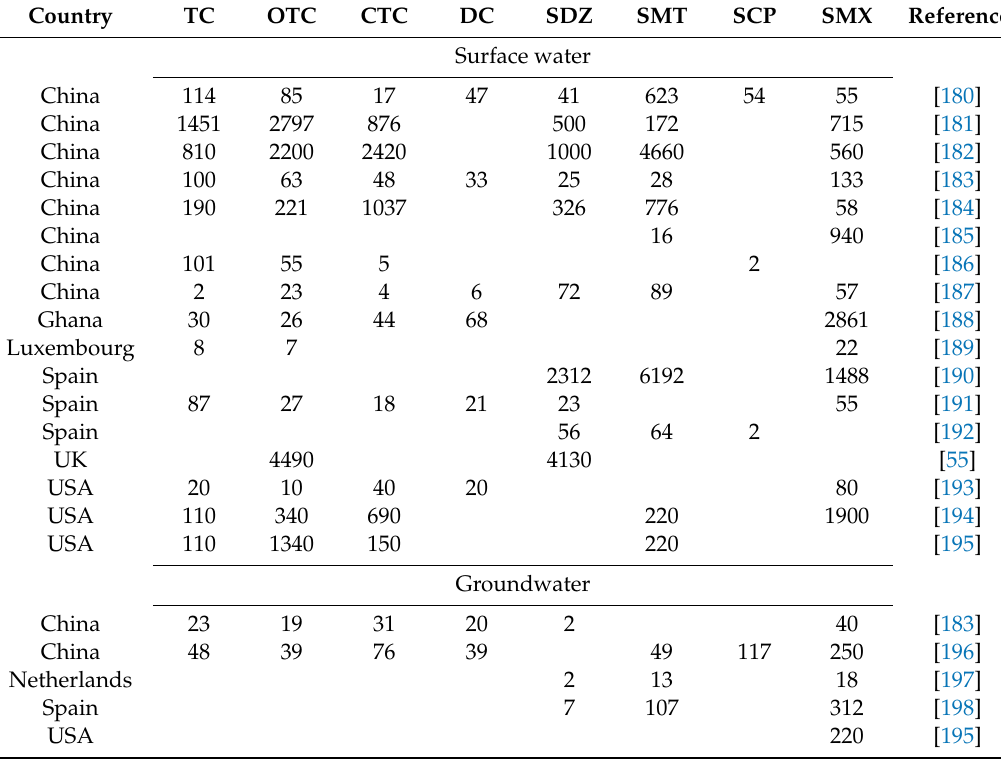
Table 11. Maximum concentrations (ng L − 1 ) of tetracycline and sulfonamide antibiotics detected in samples of surface- and